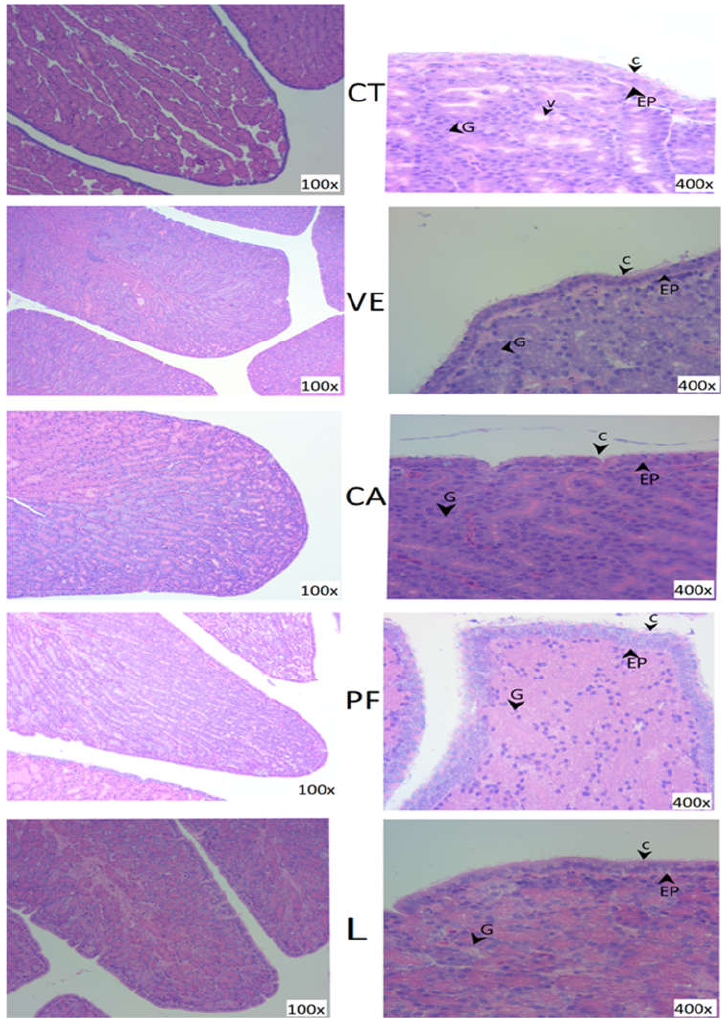
Figure 2. Hematoxylin-and-eosin-stained images of the cross section (100× magnification) or longitudinal section (400× magnification) of the magnum in laying hens (36 wk) after a 10-wk treatment period. EP = epithelium line of the mucosa; C = cilia; G = tubular glands; V = vacuole; control = CT; VE 0.02% = vitamin E; CA 0.24% = chlorogenic acid; PF 0.05% = polyphenol; and L 0.03% =